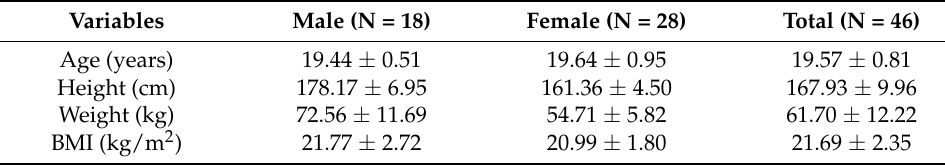
Table 1. Demographic characteristics of subjects ( M ± SD ).